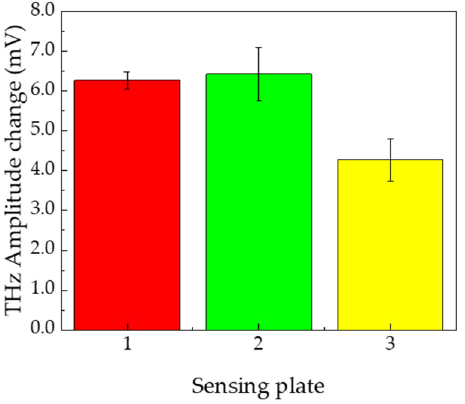
Figure 7. Average value of the change in terahertz amplitude in four wells between pH 1.68 and 10.01, for three independent sensing plates. The error bar shows the standard deviation of the average change in terahertz amplitude of the four wells on the same sensing plate. This indicates that the sensitivity was slightly deviated on the same sensing plate.